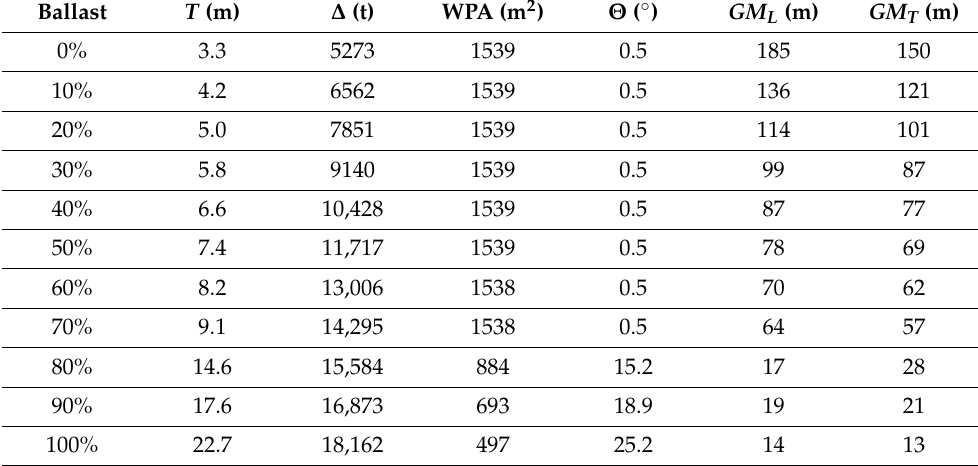
Table 7. Hydrostatic values obtained from SA: